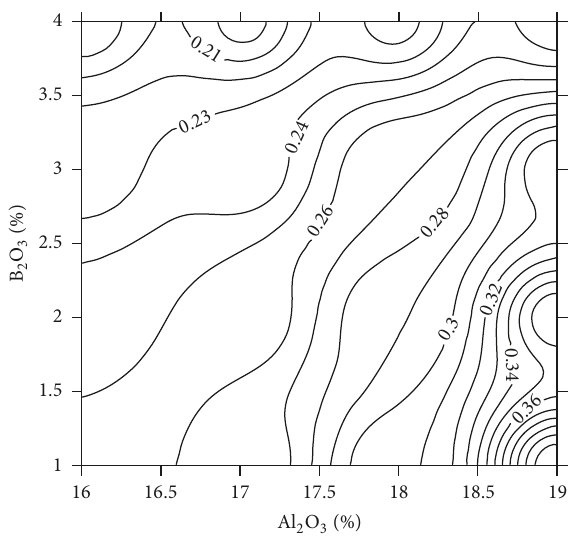
Figure 7: Effects of Al 2 O 3 and B 2 O 3 content on viscosity.